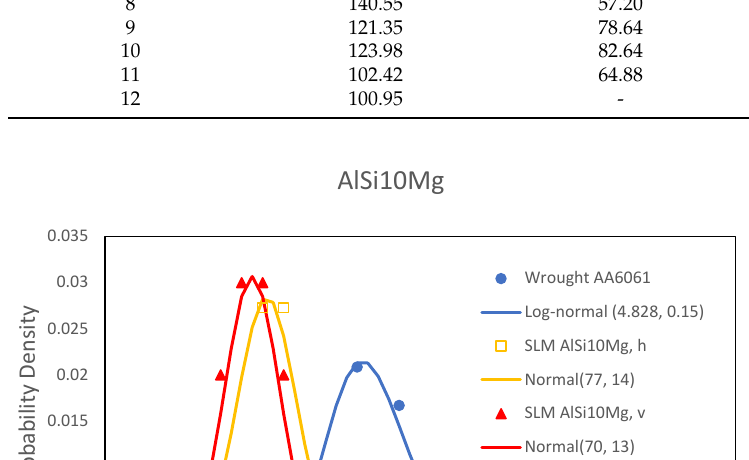
Table 11. Distribution function of fatigue endurance limit of AlSi10Mg.